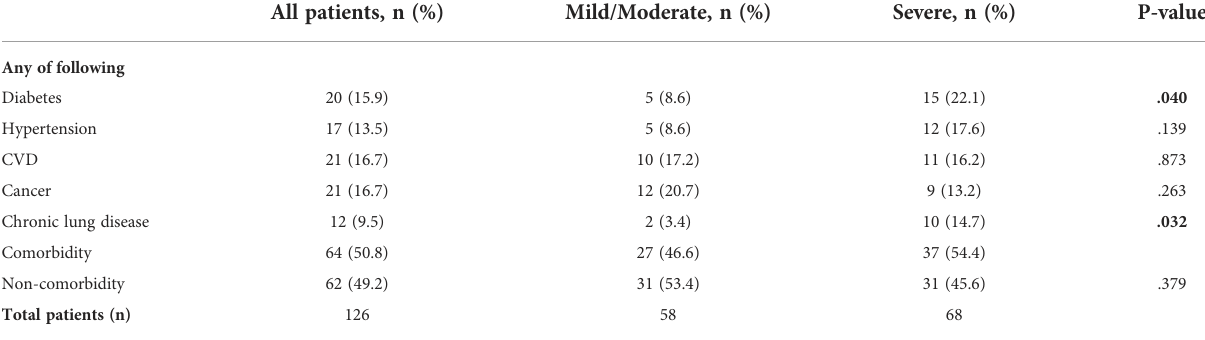
TABLE 2 Comorbidity by COVID severity classi fi cation. All patients, n (%)